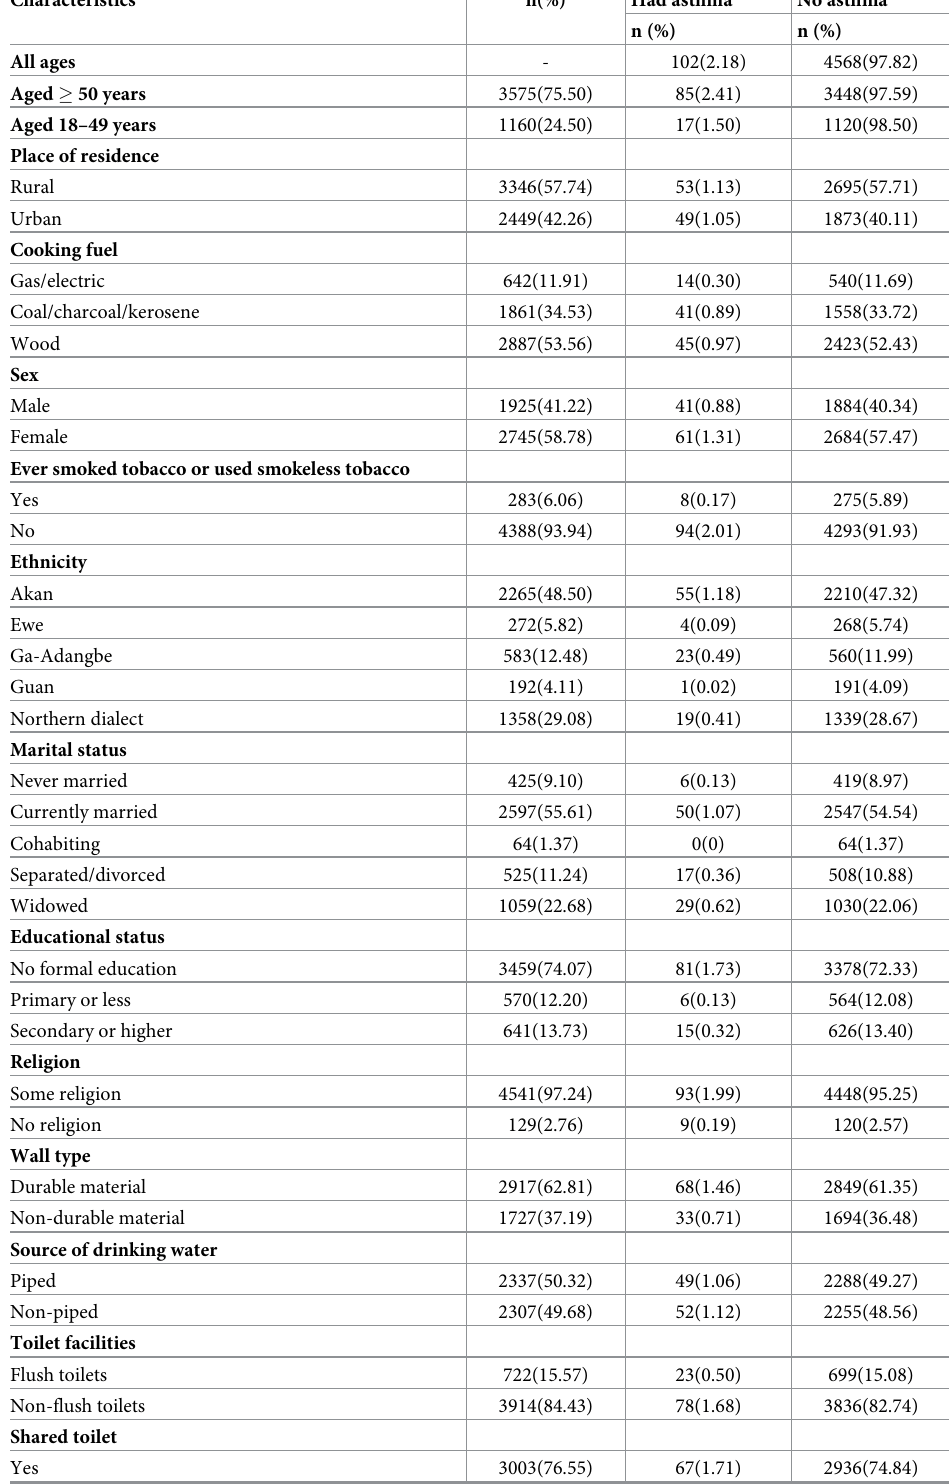
Table 1. Distribution (n, %) of selected background characteristics of